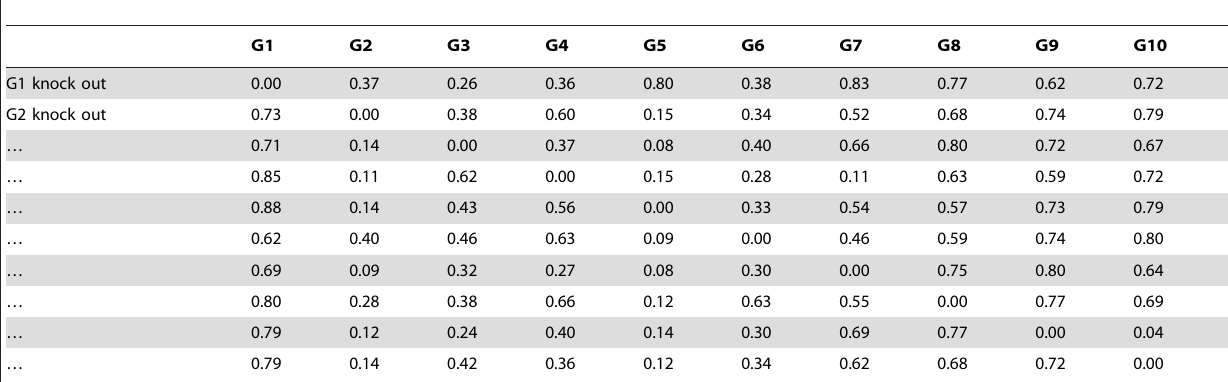
Table 6. Knock out data set, all the diagonal elements are